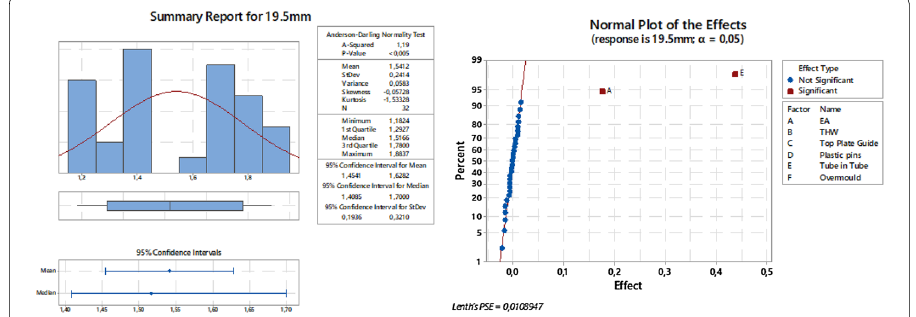
Fig. 14 Summary report for 19.5 mm collapse